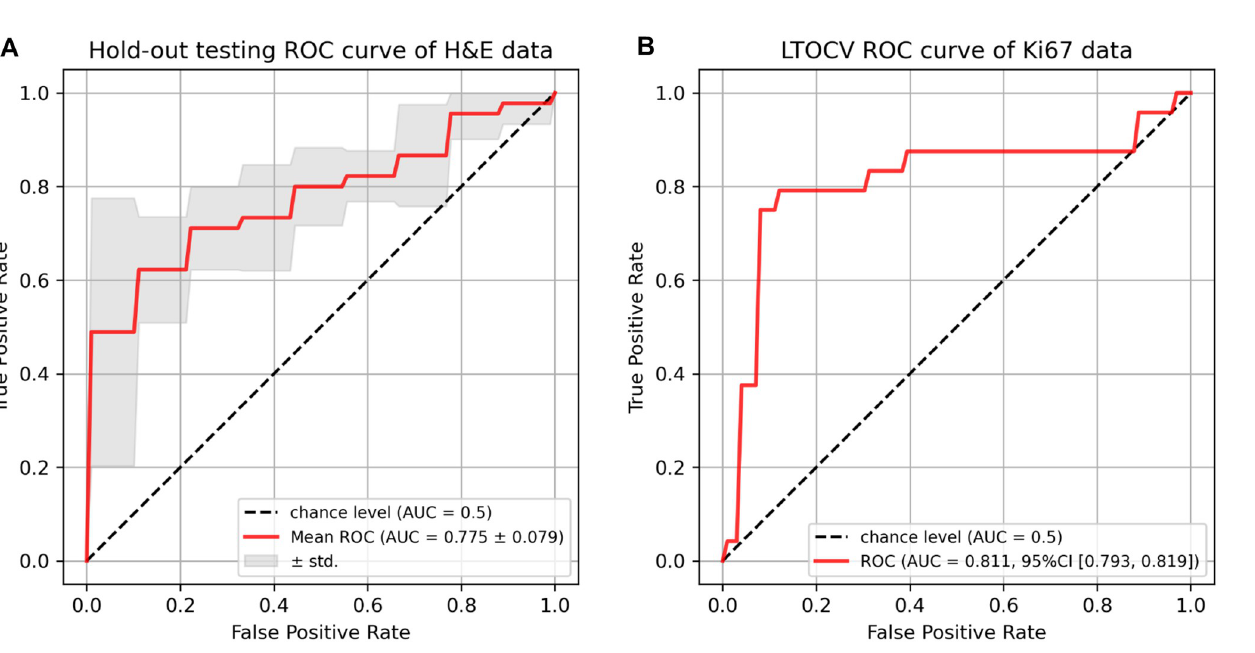
figure, we find that the validation AUCs increase as the number of samples increases. How- ever, AUCs reach a steady-state value when the number of samples in the bag exceeds a certain number. The best prediction performance for H&E and Ki67 stained slides yielded by K = 5000 and K = 3000 models correspondingly. Additionally, we investigated the patch size’s influence on our model and exhibited the results in Table 4. weights that were assigned to the WSI regions by the attention module of BCR-Net. We visual- ized the attention in the form of a heatmap, where each patch on the WSI was assigned the value of its attention weight (see Figs 10 and 11). We can easily observe that BCR-Net is paying